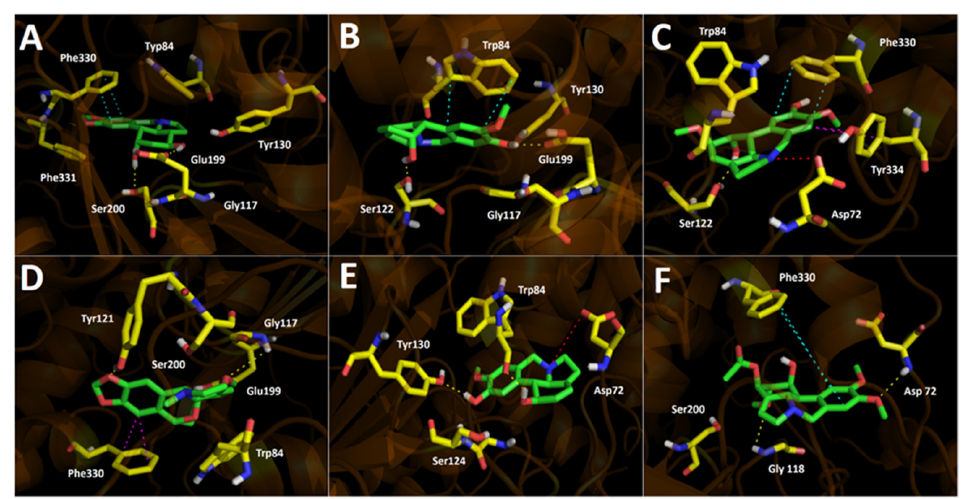
Figure 5. Predicted binding mode and predicted intermolecular interactions of major alkaloids in leaves and bulbs of Phycella cyrtanthoides extracts and the residues of Torpedo californica acetylcholinesterase ( Tc AChE) catalytic site; ( A ) 3-hydroxydihydrocaranine in the catalytic site; ( B ) Kirkine in the catalytic site; ( C ) 10- O -dimethylgalanthine in the catalytic site; ( D ) 2- α -methoxy-6- O - ethyloduline in the catalytic site; ( E ) 10-norpluviine in the catalytic site; ( F ) 3- O -acetylnarcissidine in the catalytic site. Yellow dotted lines indicate hydrogen bond interactions; cyan dotted lines represent π – π interactions; magenta dotted lines represent T-shaped interactions; and red dotted lines indicate salt bridge interactions.